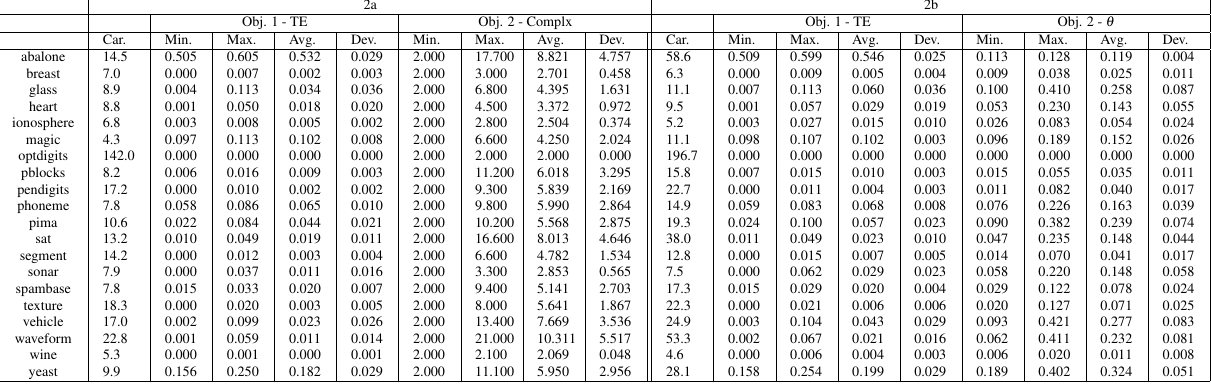
Table 3: Statistics of the Pareto front approximations with the original objectives. 2a